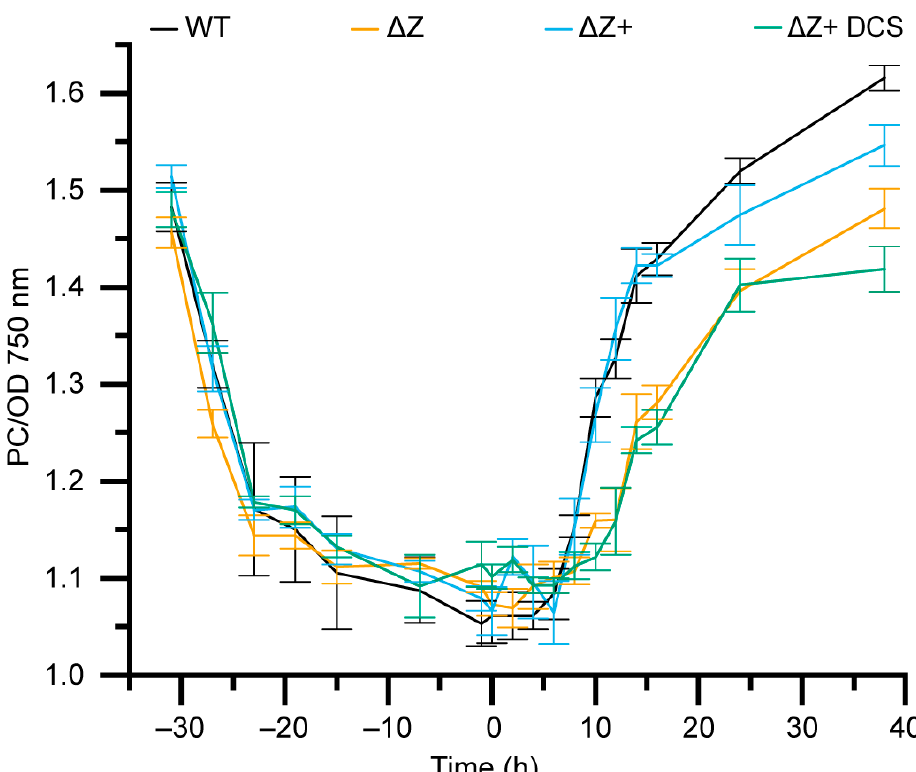
Figure 5. Time-course of nitrogen depletion and repletion. Ratio of phycocyanin to optical density 750 nm for cell lines growing under nitrogen starvation for 30 h followed by nitrogen repletion. Nitrate was added to samples at t = 0.